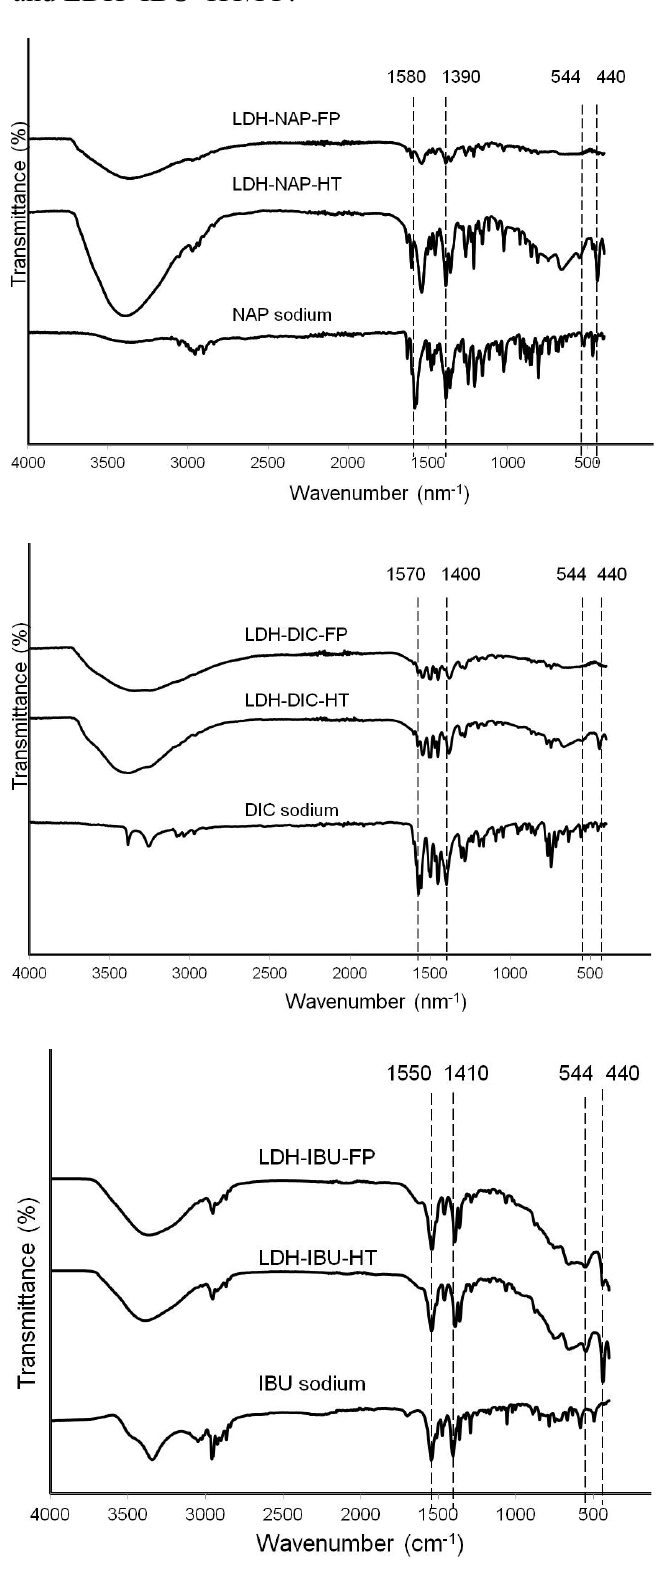
composition and drug loading capacity did not change after hydrothermal treatment, which was consistent with the observations on the crystal and chemical structure based on XRD and FTIR results. Figure 4. Fourier transform infrared (FTIR) patterns for LDH–NAP–HT/FP, LDH–DIC–HT/FP and